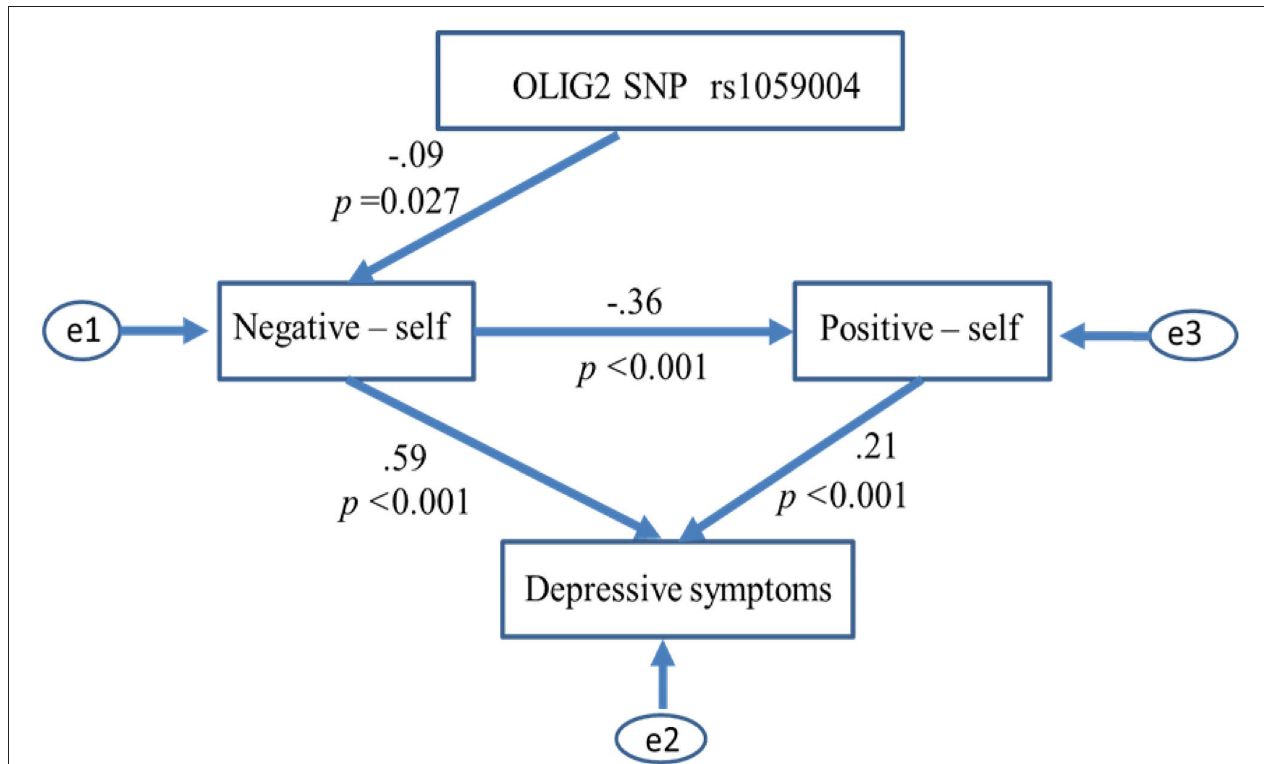
FIGURE 3 | Relationships between OLIG2 SNP rs1059004, self-core schema and depressive symptoms. Paths scoring p > 0.05 were removed from the initial models, and the best-fitting path model was ultimately adopted in the path analysis. The path model produced the best model fit results, as shown below: Chi-square = 2.669, df = 2, P = 0.263; GFI = 0.998; AGFI = 0.988; CFI = 0.998; AIC = 18.669; and RMSEA = 0.025. This path model indicates the predictive effect of the OLIG2 SNP rs1059004 on depressive symptoms via a negative self-schema (negative self) that influences a positive self-schema (positive self). SNP, single nucleotide polymorphism; GFI, goodness-of-fit index; AGFI, adjusted GFI; CFI, comparative fit index; AIC, Akaike information criterion; RMSEA, root mean square error of